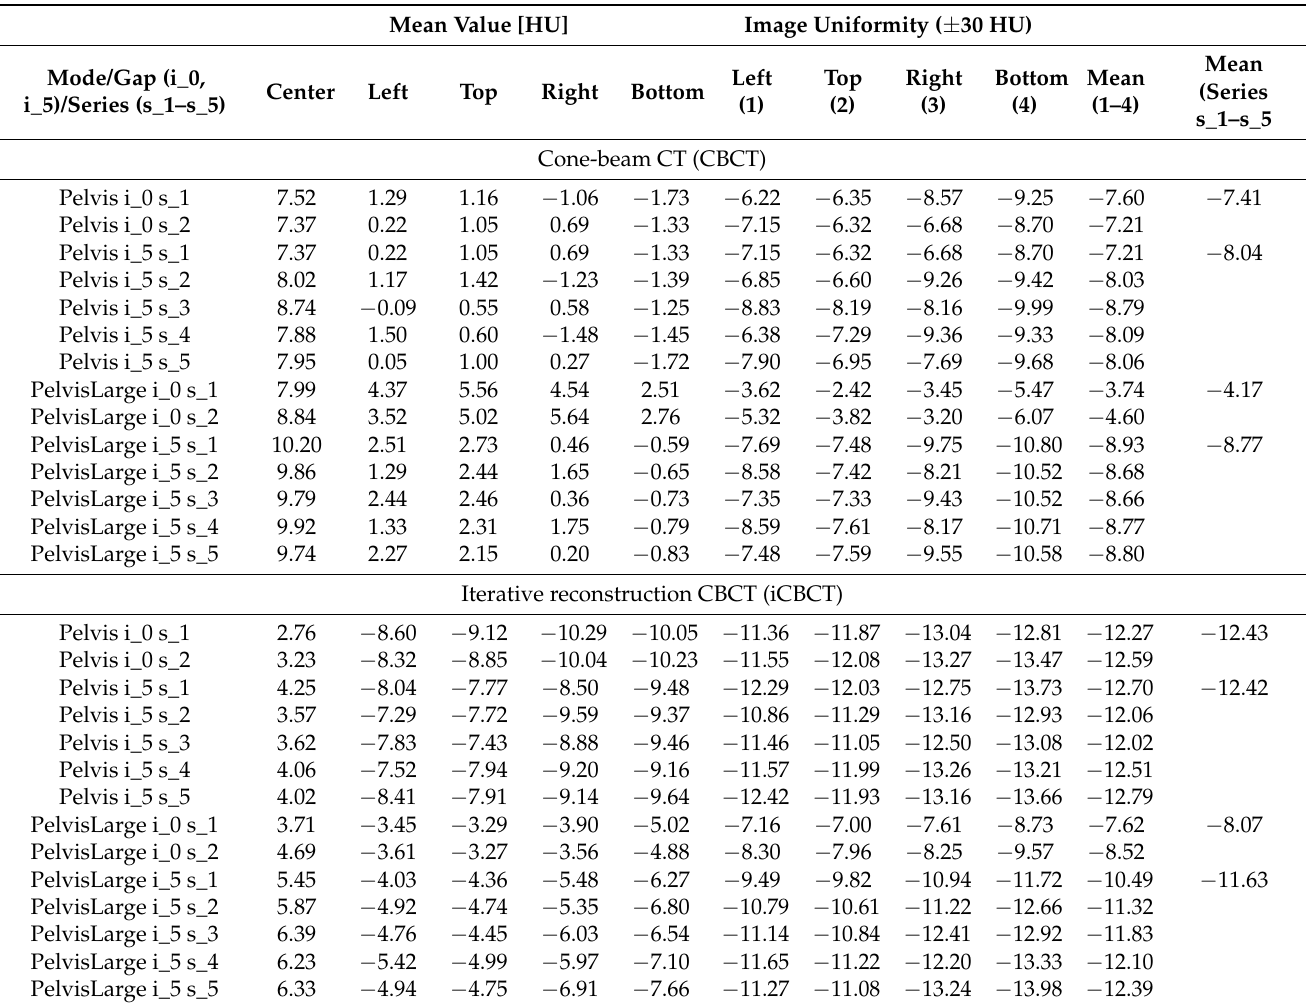
Table 7. Impact of reconstruction algorithms and modes on the image uniformity for scanning the Cathpan ® 504 phantom with the Halcyon accelerator equipped with CBCT and iCBCT. The results are shown for 0 and 5 min gaps between measurements (i_0 and i_5, respectively) for Pelvis, for 0 and ~6 min for Pelvis Large (i_0 and i_5, respectively) and for 1–5 series (s_1–s_5). VOI: 20 mm diameter, 5 mm